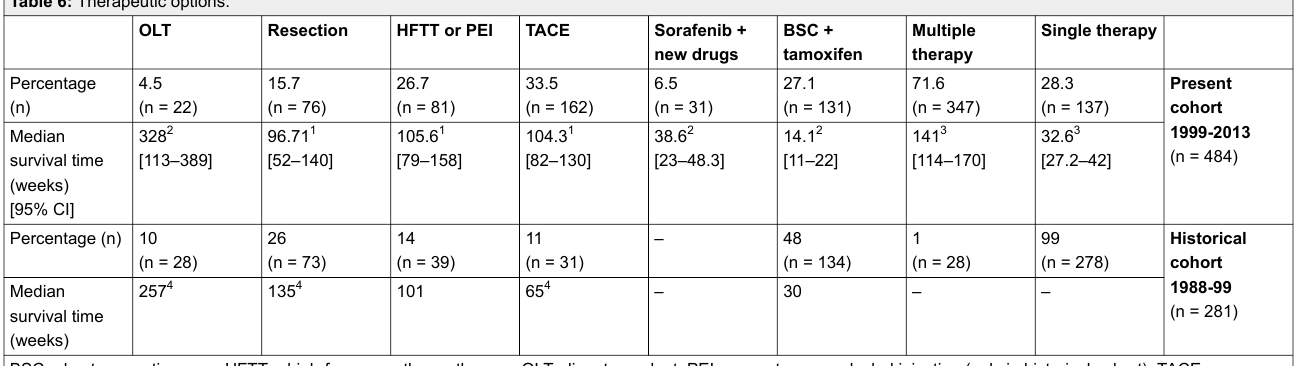
Table 6: Therapeutic